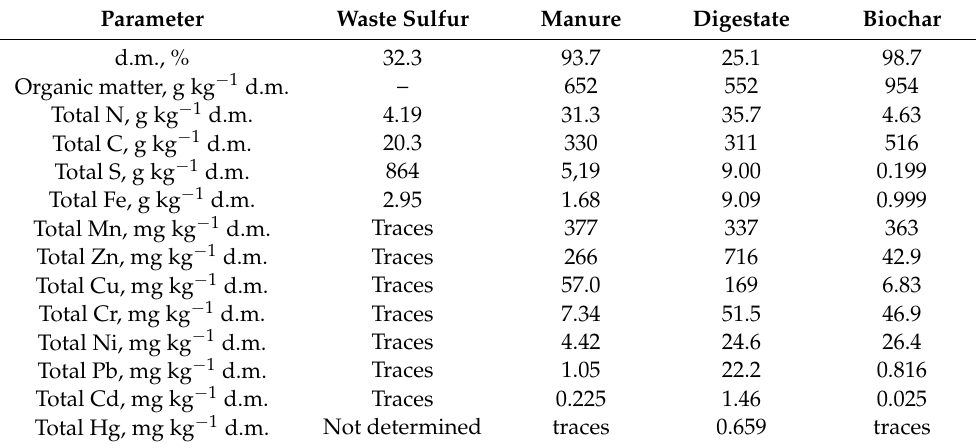
Table 3. Selected properties of materials used in the incubation